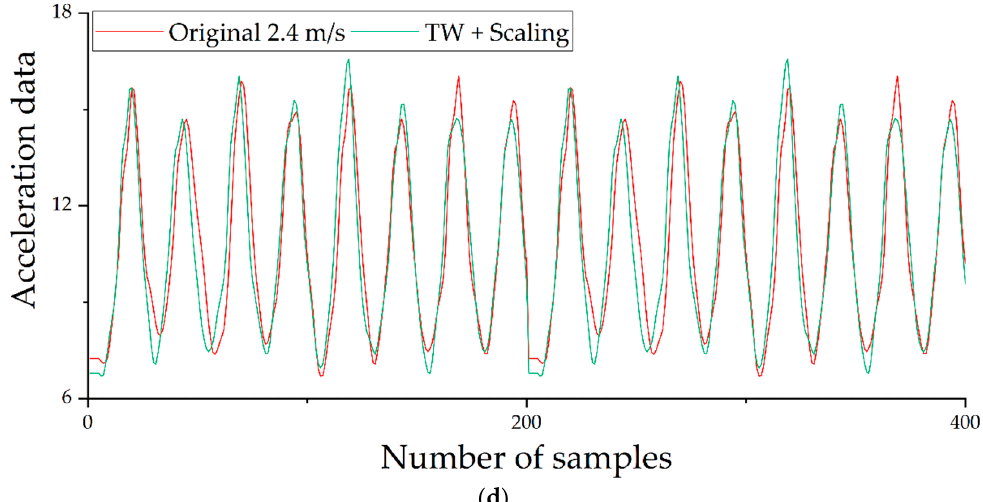
Figure 3. Acceleration x -axis data collected outdoors: ( a ) original 1.2 and 2.4 m/s data, ( b ) original 1.2 m/s and time-warped data, ( c ) original 1.2 m/s and preprocessed data, and ( d ) original 2.4 m/s and preprocessed data.